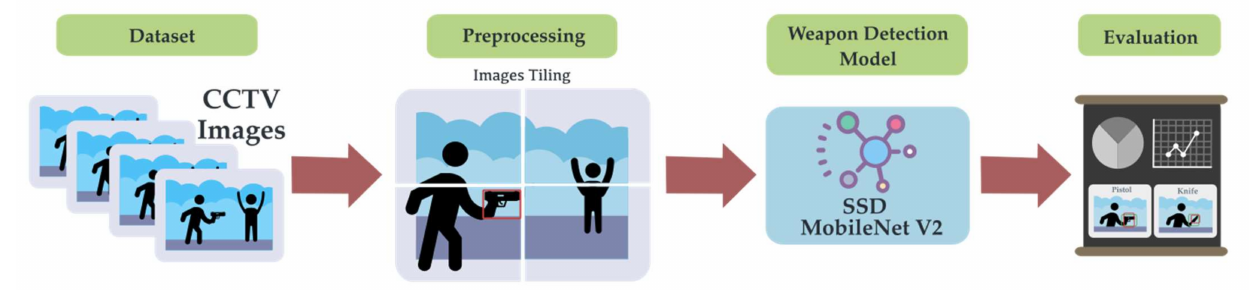
Figure 7. Methodology for weapon